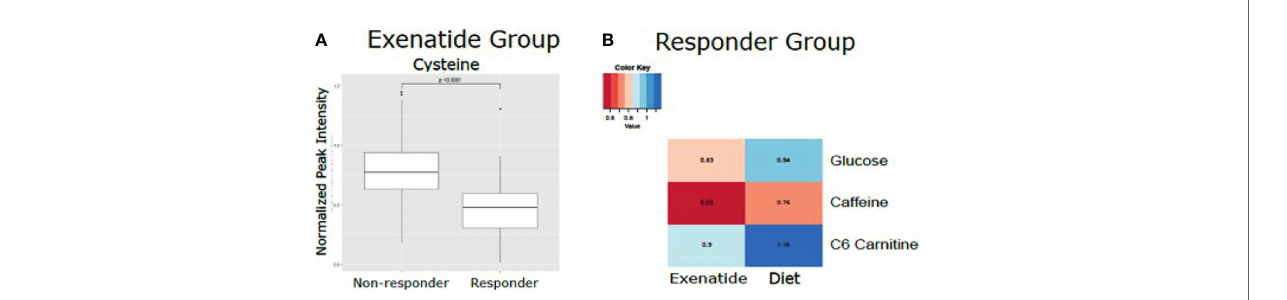
( Table 2 ). Exenatide high and low responders both showed a signi fi cant reduction in total cholesterol and LDL cholesterol,